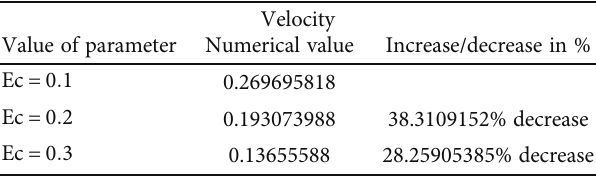
, (e) Sh , (f) τ , (g) Nu , (h) Sh , and (i) τ L L A A xL xA Table 12: Variability of the curve when Y = 1 in Figure